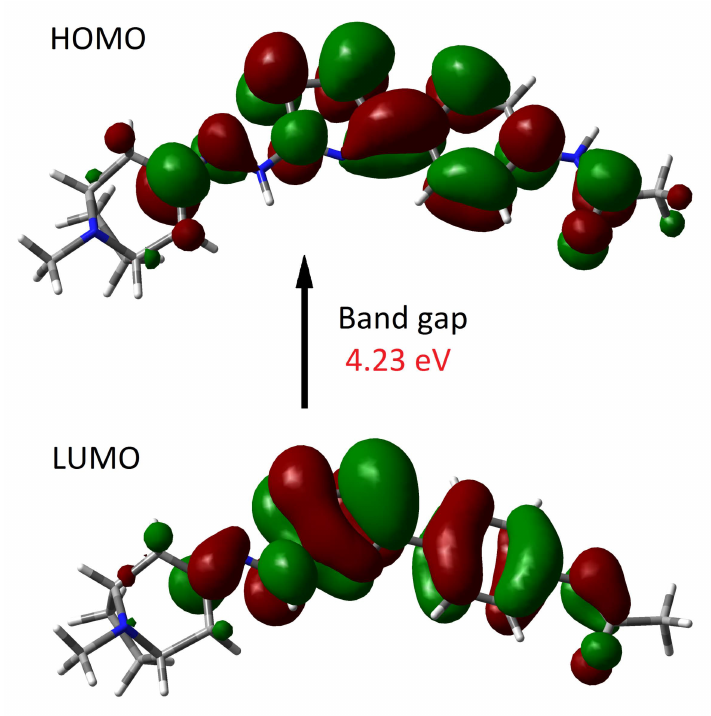
Figure 1. Molecular orbital distribution plots of HOMO-LUMO for compound 3h at the B3LYP / 6-311G**